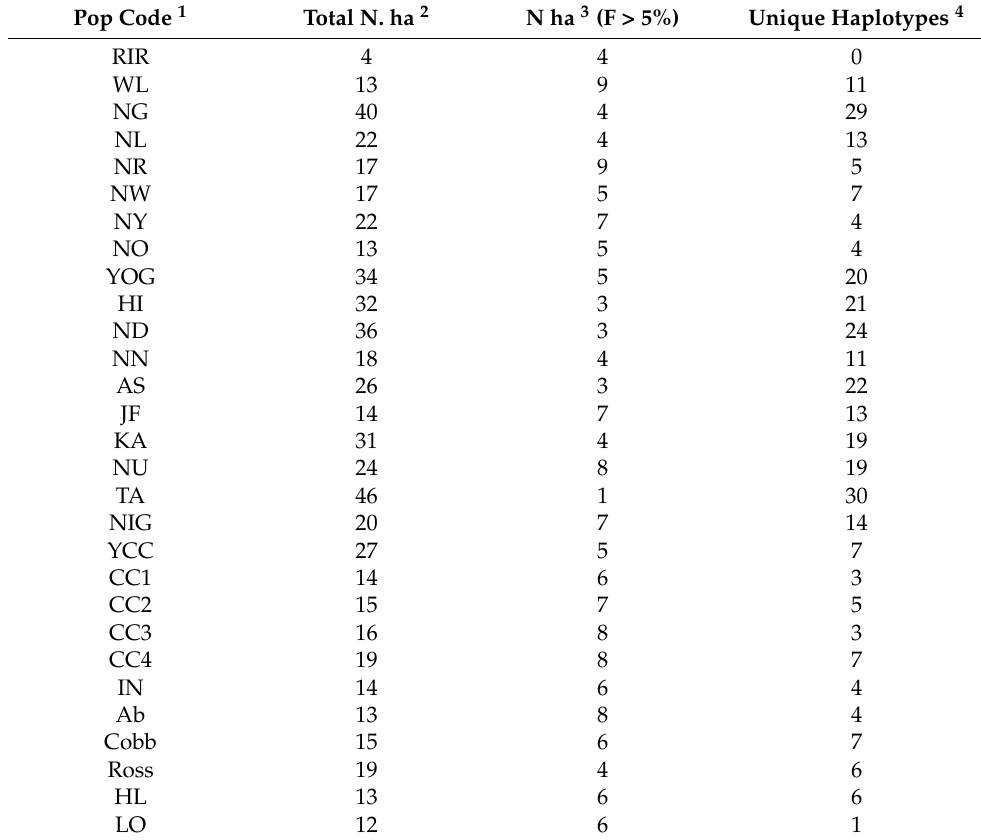
Table 6. Number of MHC- B haplotypes identified using Set 2 microsatellite